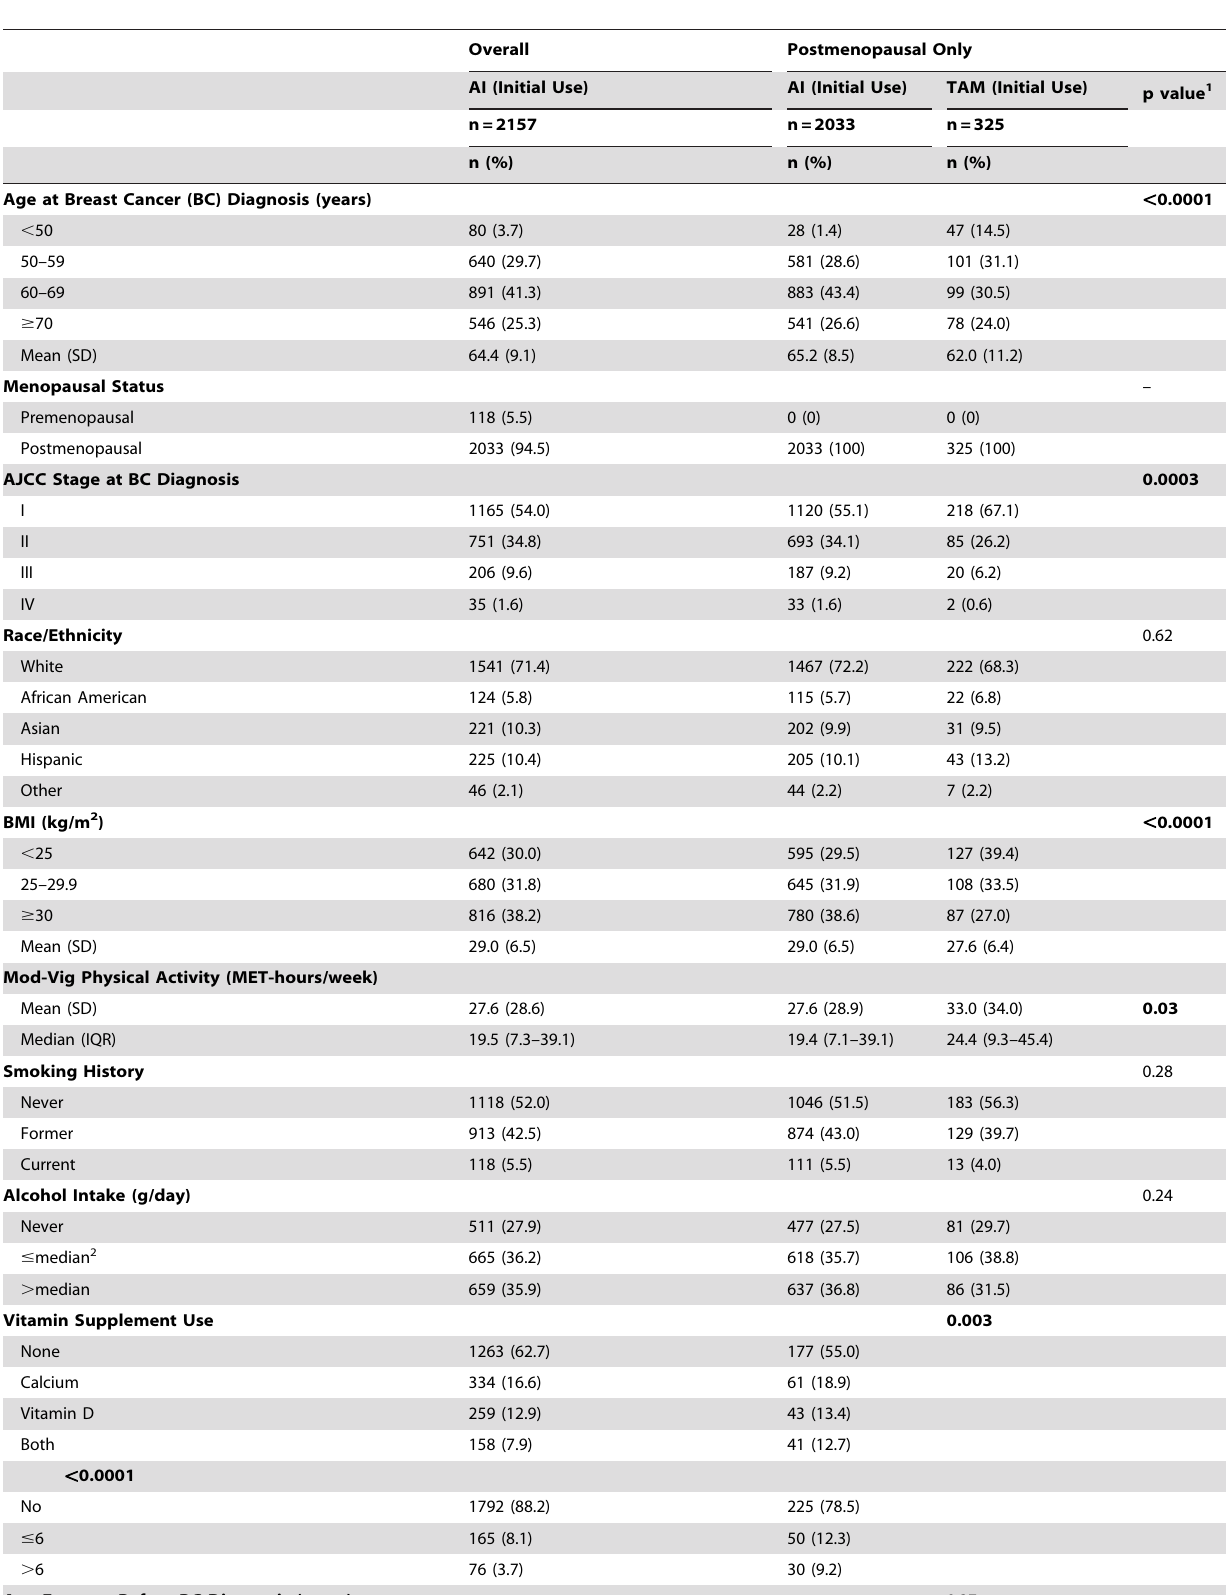
Table 1. Baseline characteristics of study cohort by initial use of aromatase inhibitor (AI) or tamoxifen